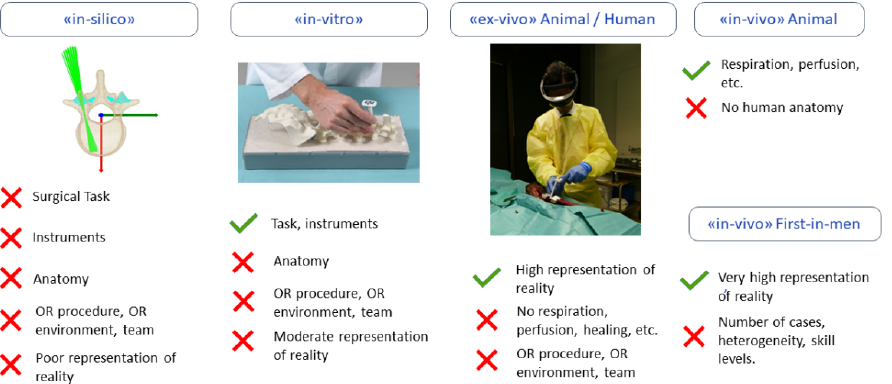
Figure 2. Validation models that are utilized in the different development stages of medical AR systems. For each validation model the included ( ✓ ) and excluded ( ✕ ) validation capabilities and components are indicated below each model, respectively. In the translational research process of medical AR systems, “in silico” and “in vitro” validation models are typically used in TRL3, “ex-vivo” animal studies are usually applied in TRL4, “ex vivo human” and “in vivo” animal experiments are performed in TRL5, and an “in vivo first in-man” study is performed in TRL6, as described in the following paragraphs.